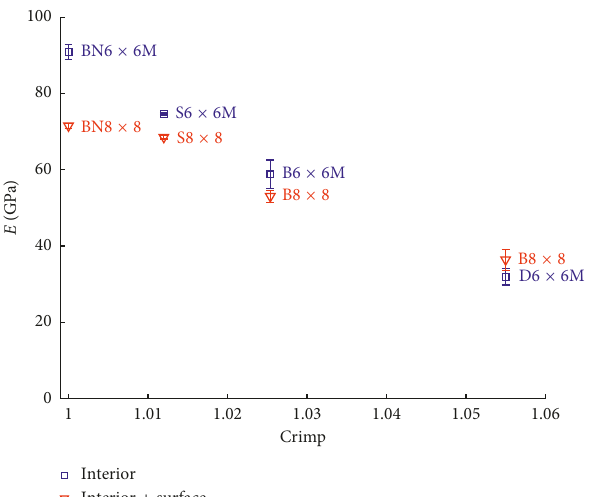
Figure 6: The Young modulus of composite specimens containing 3D-woven and noobed reinforcement. Results from both pristine (I+S) and milled (I) specimens are Table 2: The Young moduli (GPa), measured and estimated from equation (2). Textile type Plain 3D woven Noobed 3D woven with stuffer